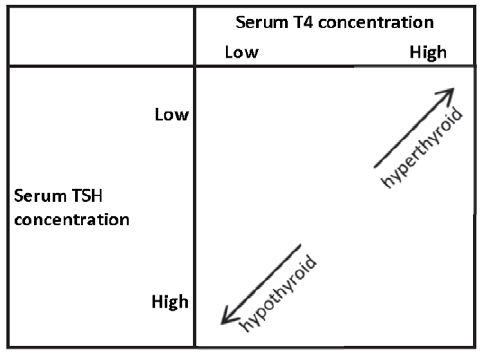
Figure 1. Hypothyroid and hyperthyroid hormone profiles by serum concentrations of T4 and TSH.